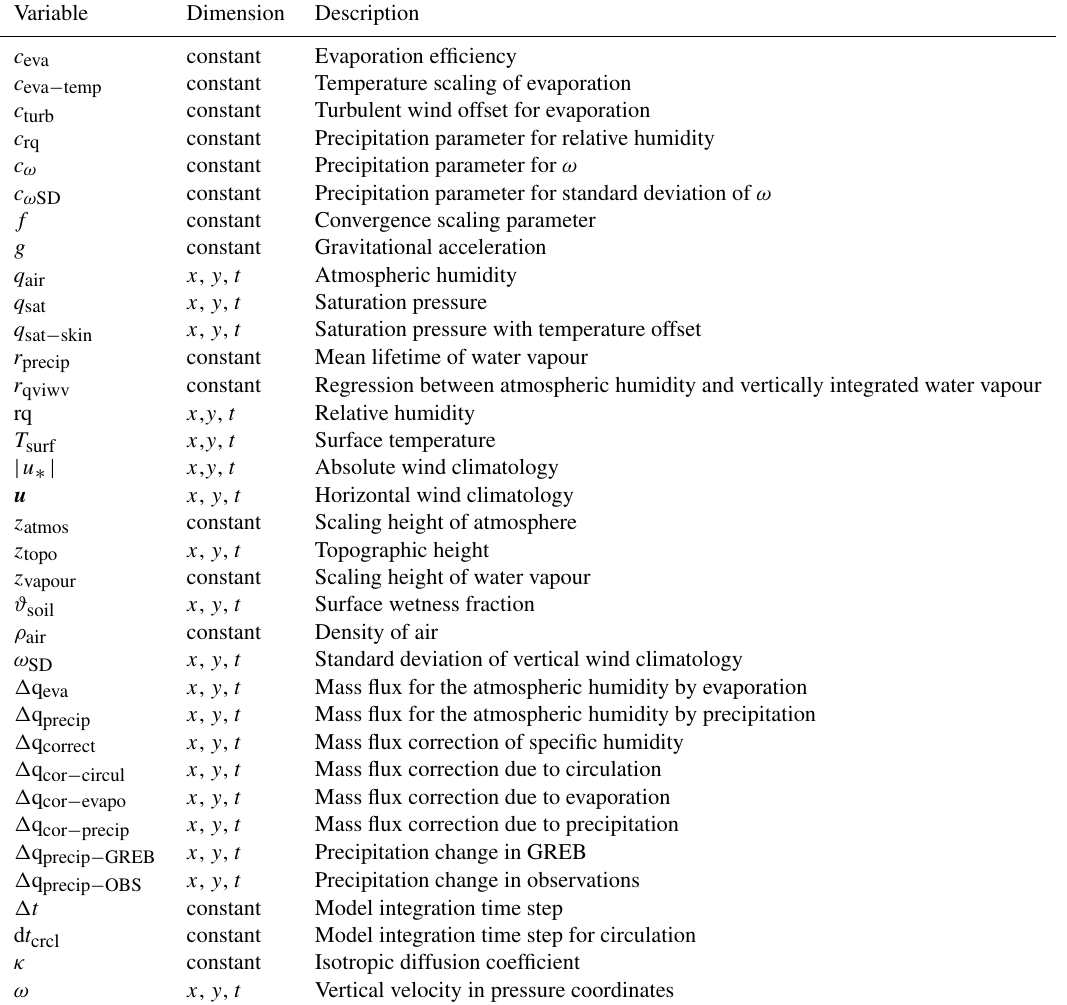
Table 2. Variables of the GREB